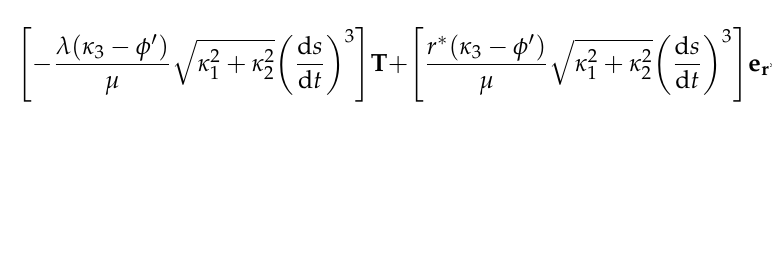
Figure 2. The motion of point particle P along a quasi plane curve α that contains a fixed origin O . Consequently, we can say that the